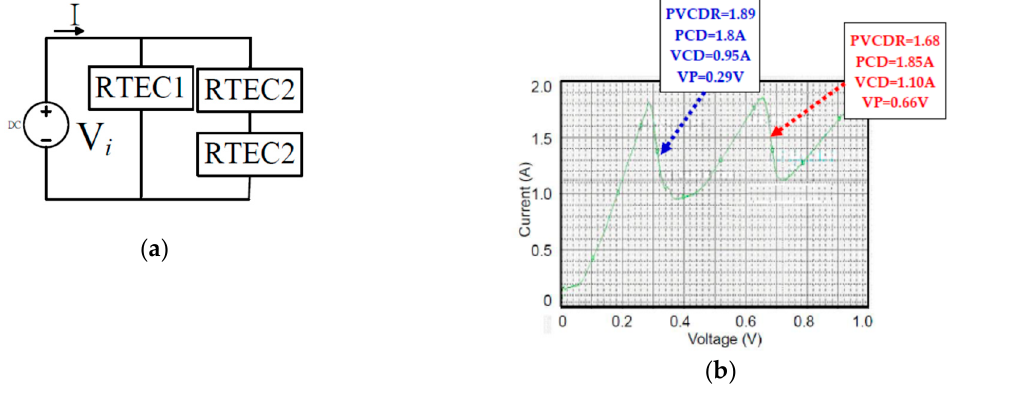
Figure 7. ( a ) The second improvement method by the double PVCDR RTEC structure in series with another RTEC unit. ( b ) Improvement of NDR characteristic by the method of the double PVCDR RTEC structure in series with another RTEC unit.